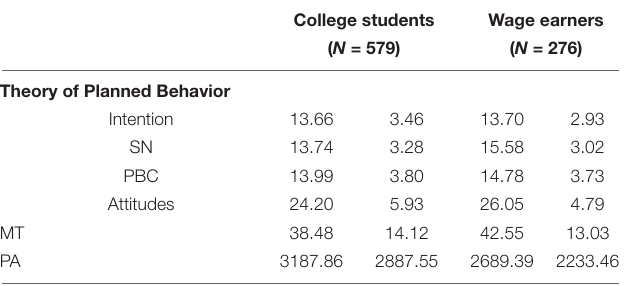
TABLE 1 | Mean and standard deviation for attitudes, subjective norms (SN), perceived behavioral control (PBC), intention, mental toughness (MT), and physical activity (PA).